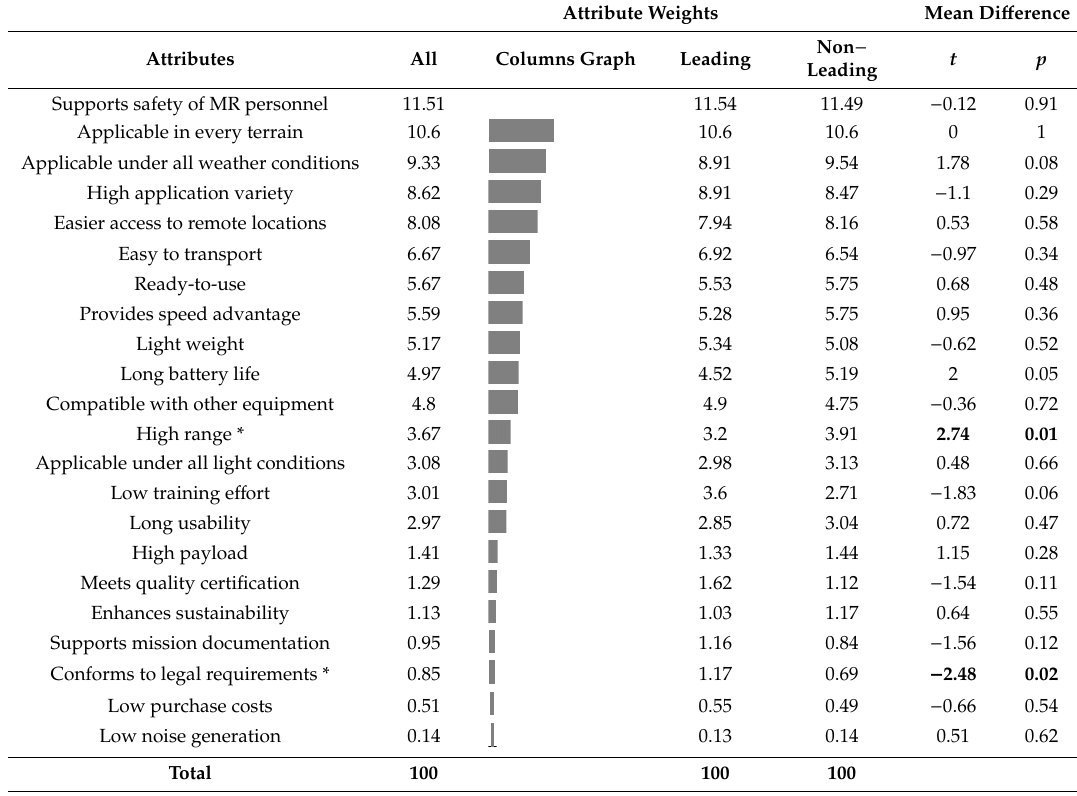
Table 2. Comparison of average attribute weights as derived from hierarchical Bayes (HB) analysis of the online best–worst scaling (BWS) survey between leading and non ‐ leading mountain rescue (MR) ‐ members including t ‐ statistic and p ‐ value.